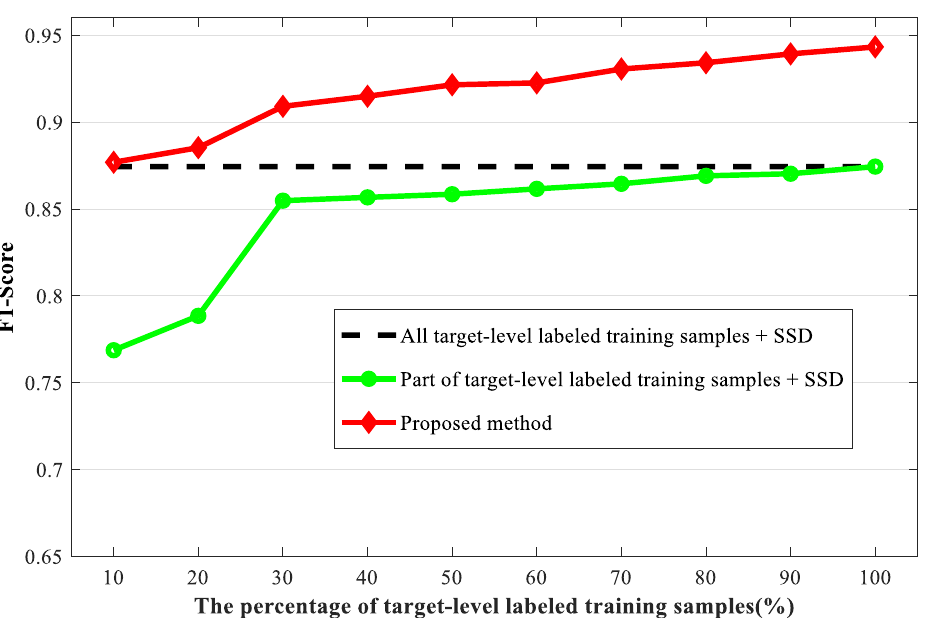
Figure 8. The detection performance against the percentage of target-level labeled training samples.